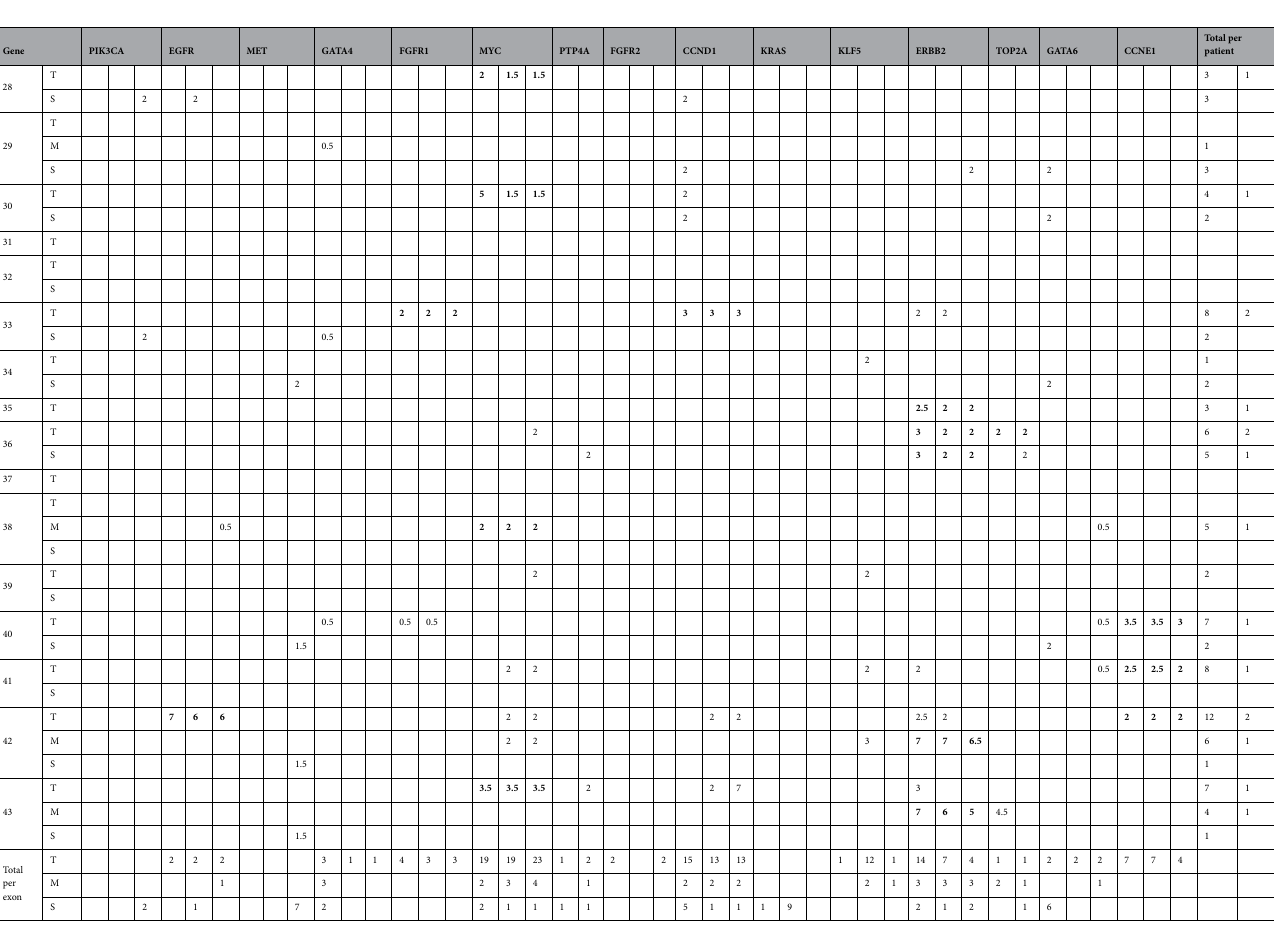
Table 2. CNV in primary tumor, serum and lymph node metastasis of 43 UCB patients treated with RC. Bold values refer to the copy number variation of all investigated (2 or 3) exons of the gene.